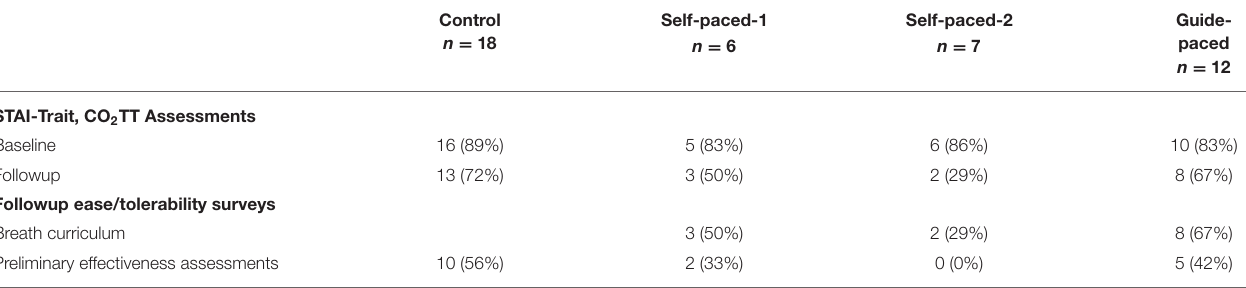
TABLE 2 | Descriptive data for number (%) of participants completing baseline and follow-up measures, by